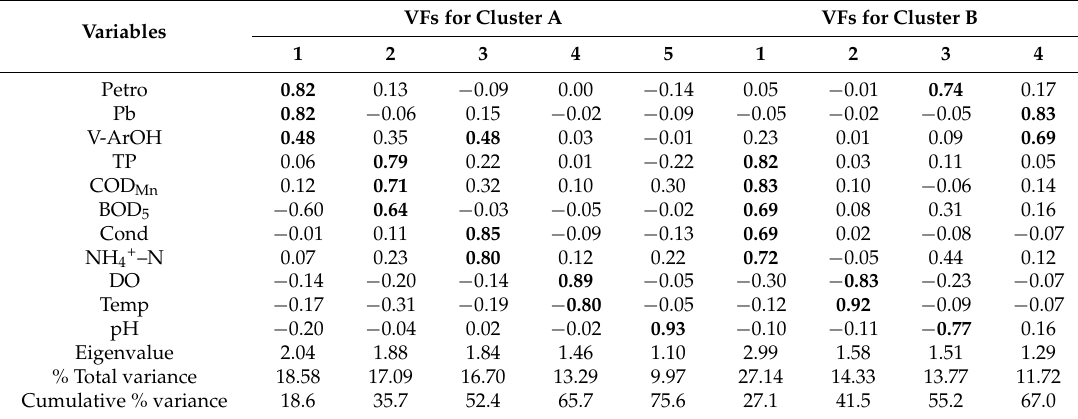
Table 3. Loadings of 11 measured variables on VARIMAX rotated factors of two clusters.